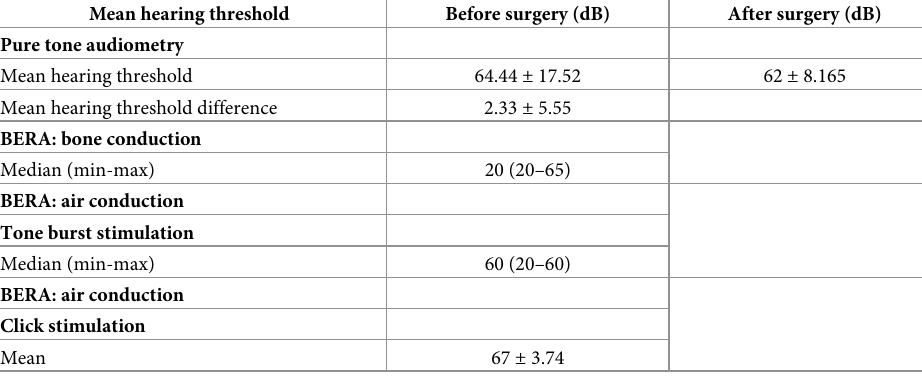
Table 2. Audiometry results of the patients with microtia.